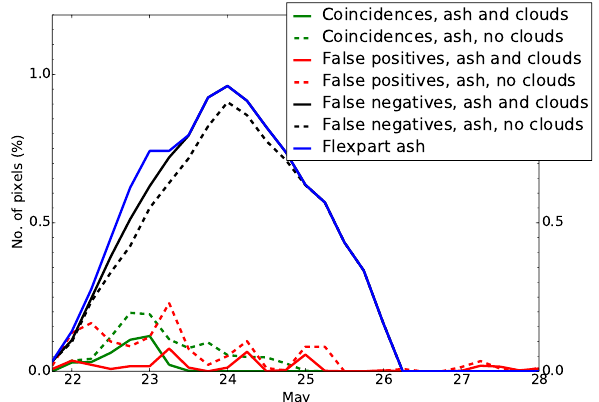
Figure 13. Similar to Fig. 8, but for the Grímsvötn (2011) eruption.